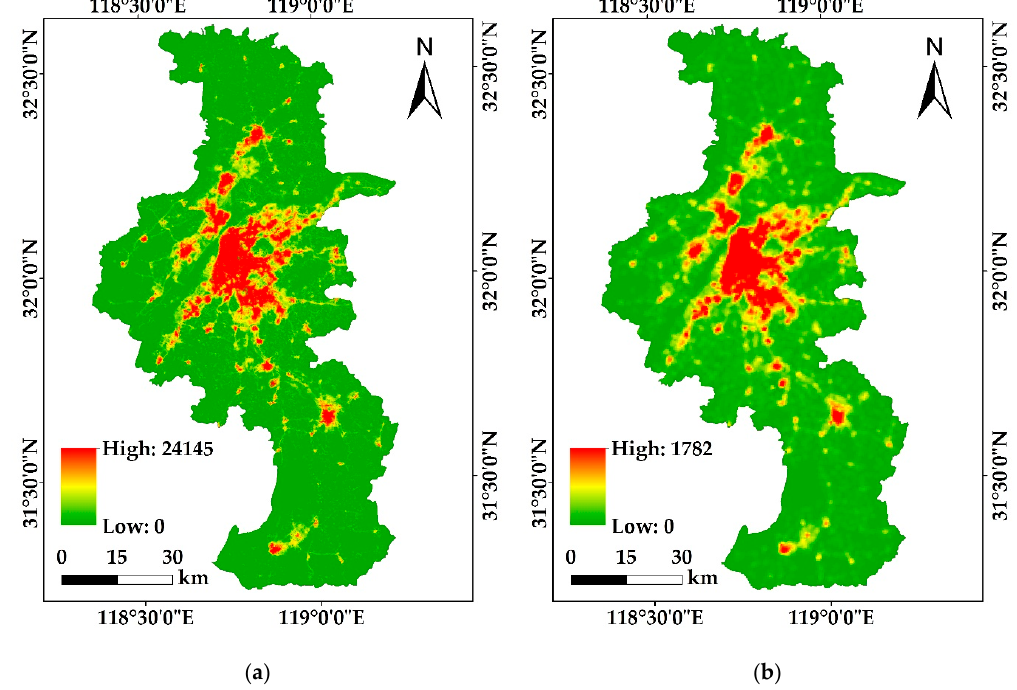
Figure 3. PLANUI images of the study area: ( a ) LJ-PLANUI; ( b )